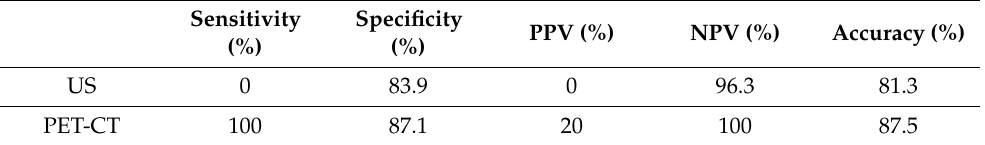
Table 2. Sensitivity, specificity, positive predictive value, negative predictive value and accuracy of US and